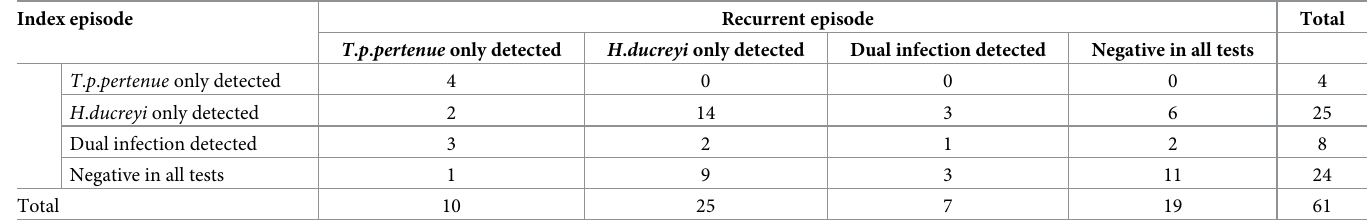
Table 3. Etiology of recurrent cutaneous ulcers according to the type of the index episode in patients identified during a public health intervention for yaws eradica- tion (active case detection). Data correspond to 61 ulcers detected among 50 individuals with PCR